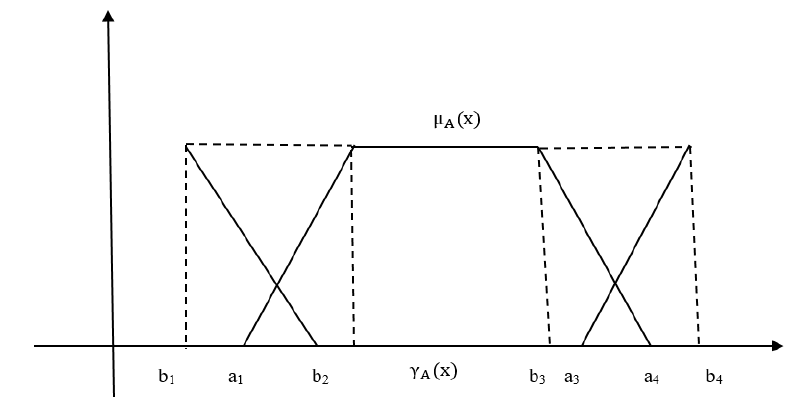
Fig. 1. Trapezoidal intuitionistic fuzzy